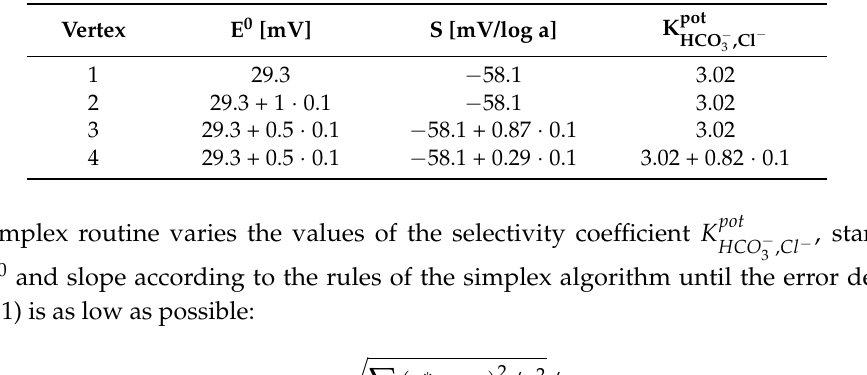
Table 4. The values of initial vertices of the simplex